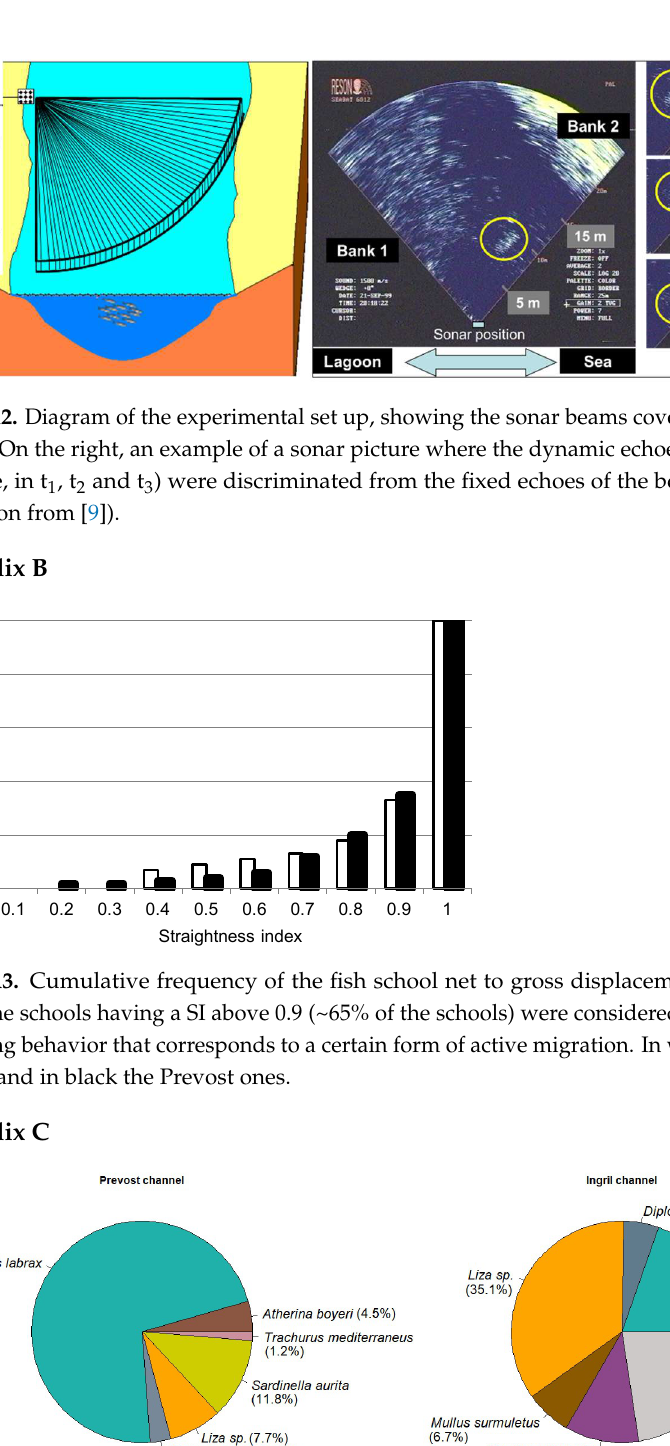
Table A1. Raw experimental data used for this study and extracted from [8,9], the Straightness index (SI) was the Beeline value divided (D) by the Path Length (L), calculated as SI = D/L. Below the theoretical function of limiting factor to the sampling protocol.